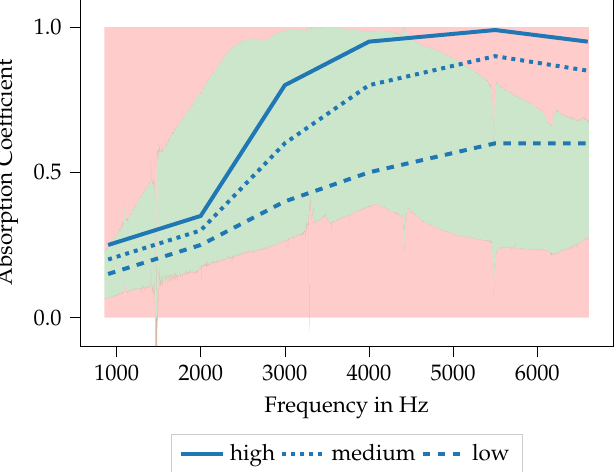
Figure 14. Target curves for the porous absorber design. Red and green areas mark known/unknown regions that are/are not covered by the existing specimen yet. The target curve “low” lies completely within the known data range, it is assumed that here only interpolation within the available data is required. The target curves “medium” and “high” leave the known range above approx. 5000 Hz, here the ability to extrapolate from the known data is